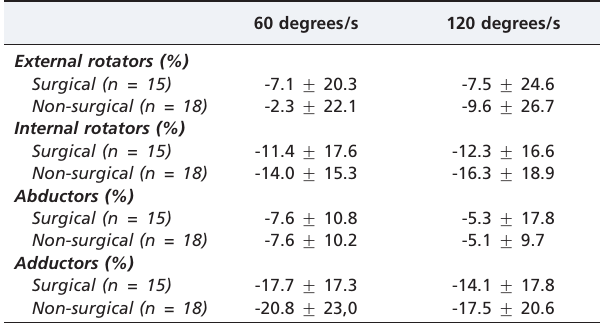
Table 3 - Contralateral deficiency between the injured and uninjured sides in athletes who had undergone surgical and non-surgical